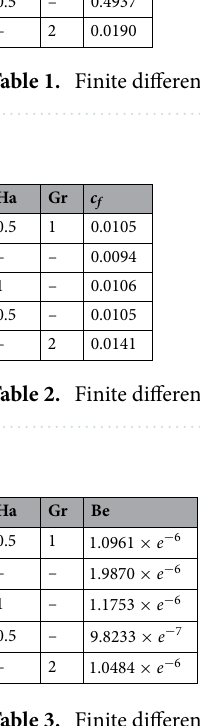
Table 3. Finite difference results for Bejan